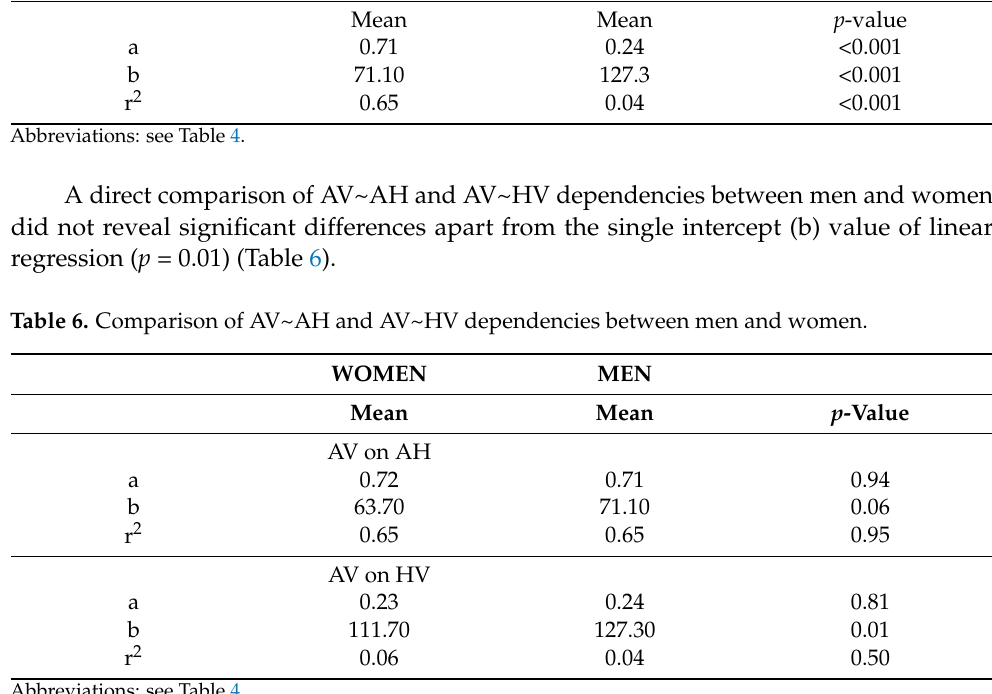
Abbreviations: see Table